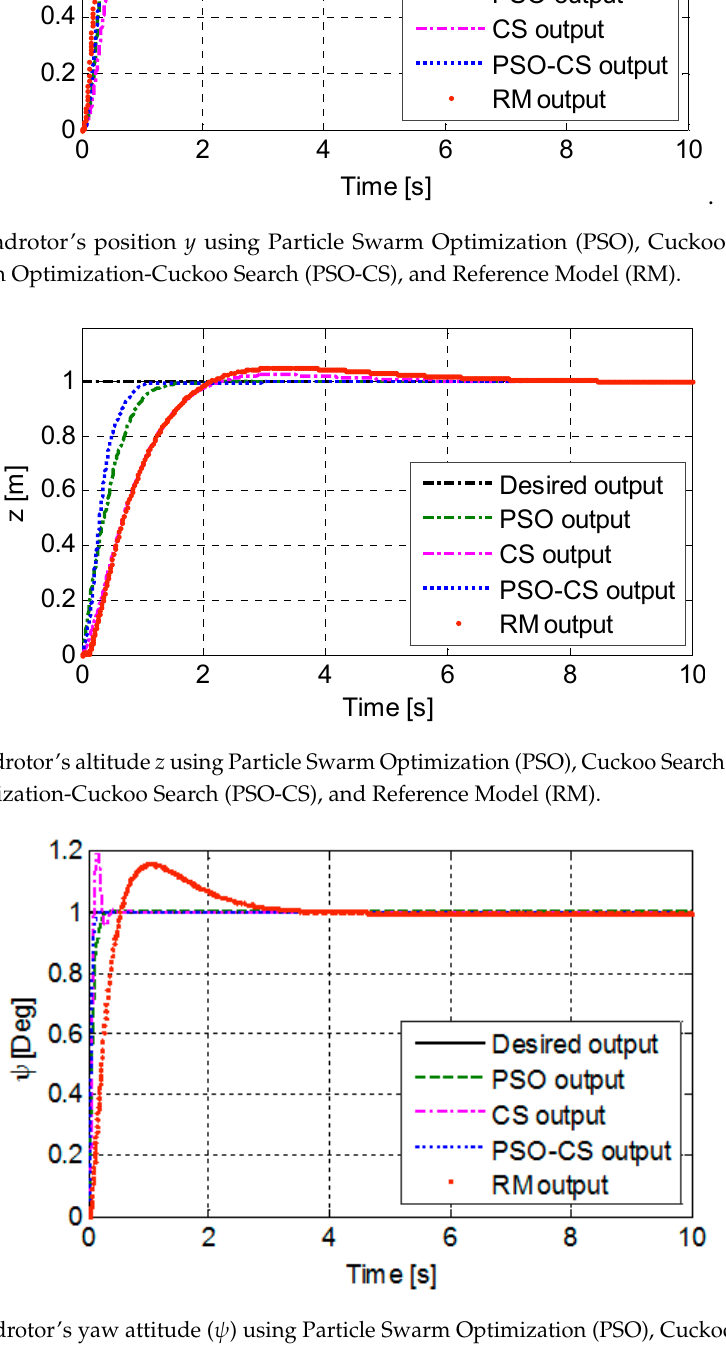
Figure 6. Quadrotor’s yaw attitude ( ψ ) using Particle Swarm Optimization (PSO), Cuckoo Search (CS), Particle Swarm Optimization-Cuckoo Search (PSO-CS), and Reference Model (RM).